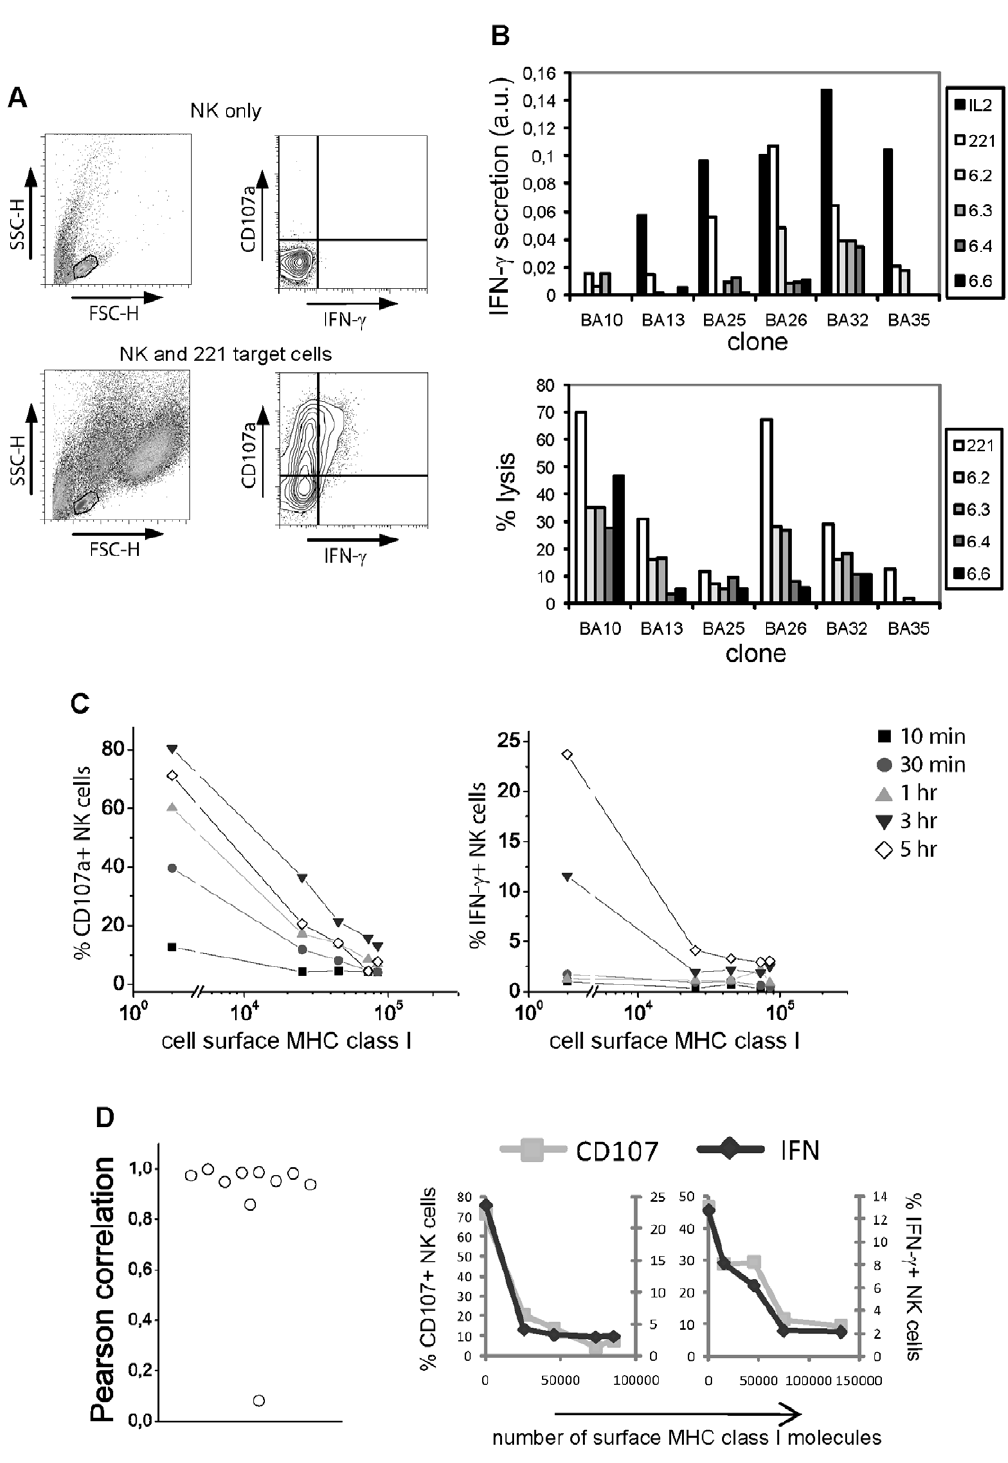
Figure 2. CD107a degranulation and IFN- c production by different human NK cell clones. A ) Induction of CD107a and IFN- c are not correlated. NK cells were co-incubated with (bottom) or without (top) 221 target cells and analysed by flow cytometry. NK cells were selected on the basis of size (left; FSC-H stands for Forward Scatter and correlates with the cell volume while SSC-H stands for Side Scatter and correlates with the granularity of the cell; NK cells are the smaller cells, while the larger events correspond to target cells) and analysed for CD107a degranulation and IFN- c intracellular staining (right). B ) Top: Amount of IFN- c , determined by ELISA, secreted by different NK cell clones incubated for 72 hr with 100 U/ ml IL-2, or in the presence of irradiated target cells (221 cells expressing no MHC class I, or target cell clones 6.2, 6.3, 6.4 or 6.6, expressing an increasing number of surface MHC class I molecules per cell – Table 1). Bottom: Percent of lysed target cells by NK cell clones as determined by 5 hr radioactive release assays (bottom), using the same target cell clones. C ) CD107a degranulation (left) and IFN- c production (right) by NK cells incubated with different target cells for different times. Data shown was obtained with an NK cell line, and are representative of data acquired with two NK clones and one polyclonal NK cell line. D ) Correlation between inhibition of NK cell CD107a degranulation and IFN- c production. NK cell